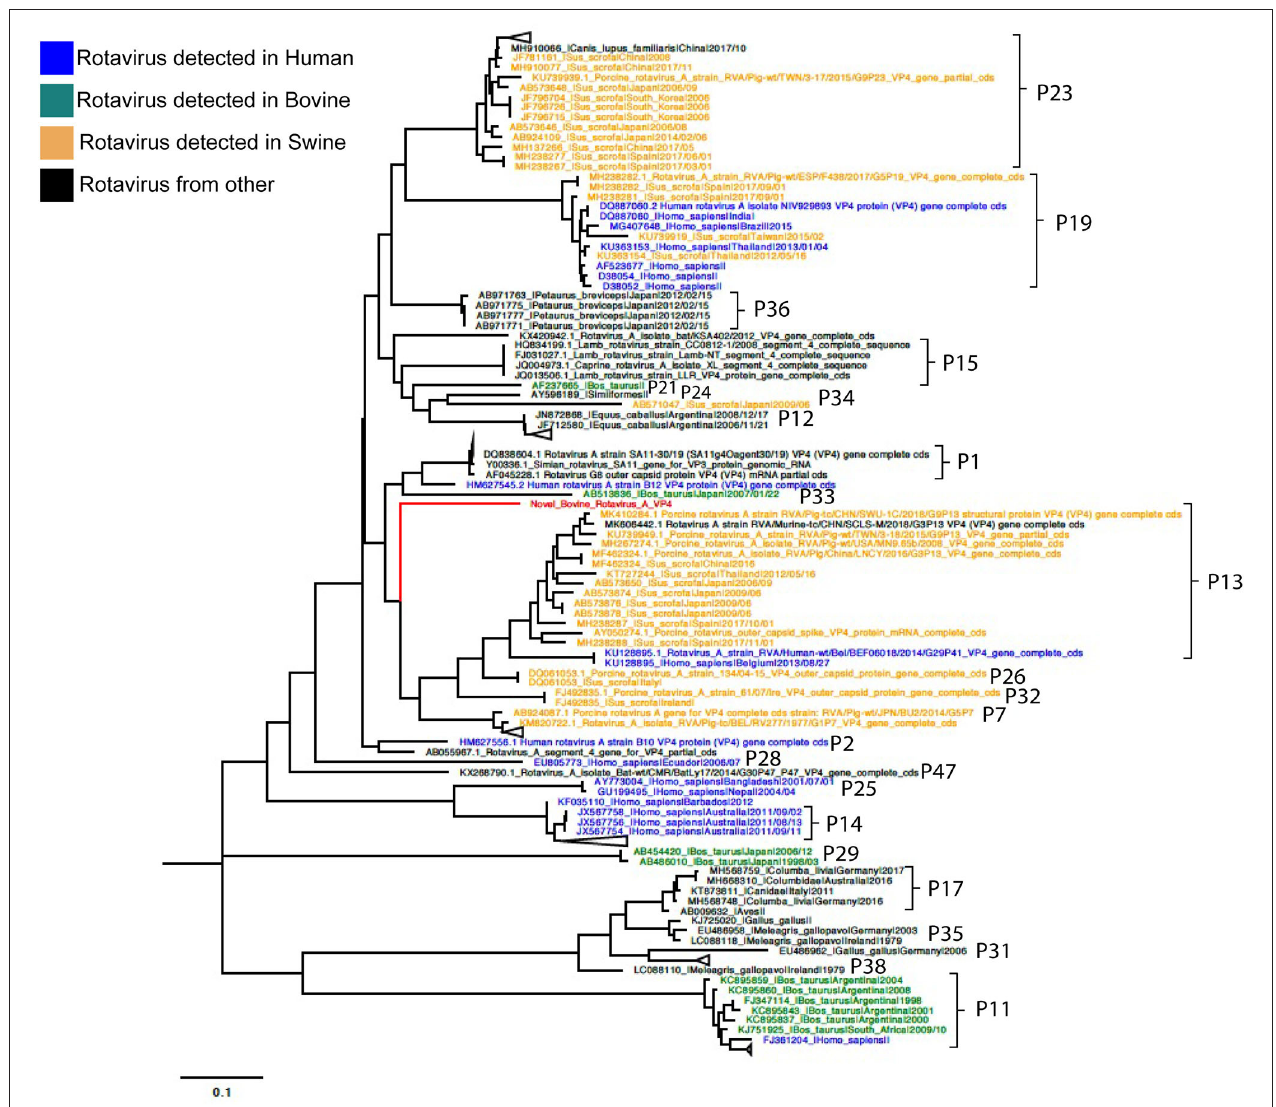
FIGURE 2 | Phylogenetic tree of VP4 RVA segment using ML GTR + R 1,000 replicates. Reference sequences are depicted in blue for human origin rotaviruses, green for bovine origin rotaviruses, and orange for swine origin rotaviruses. Novel rotavirus sequence is depicted in